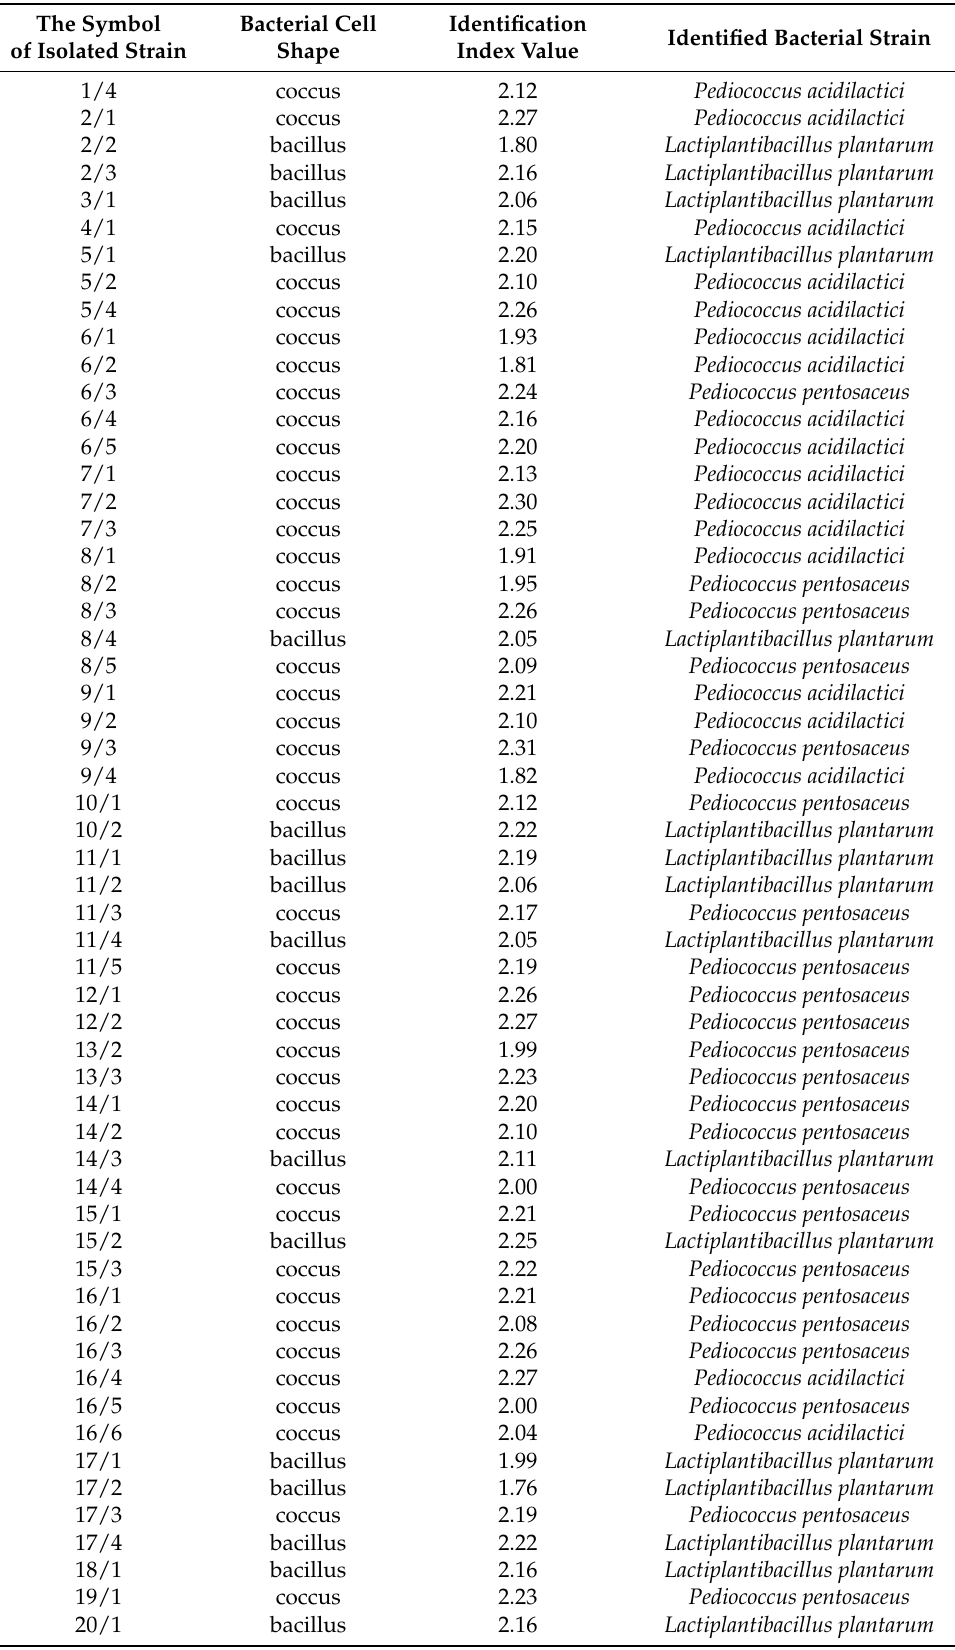
Table 5. Identification of LAB strains from honeybee environment and honeybee products using MALDI-TOF mass spectrometry